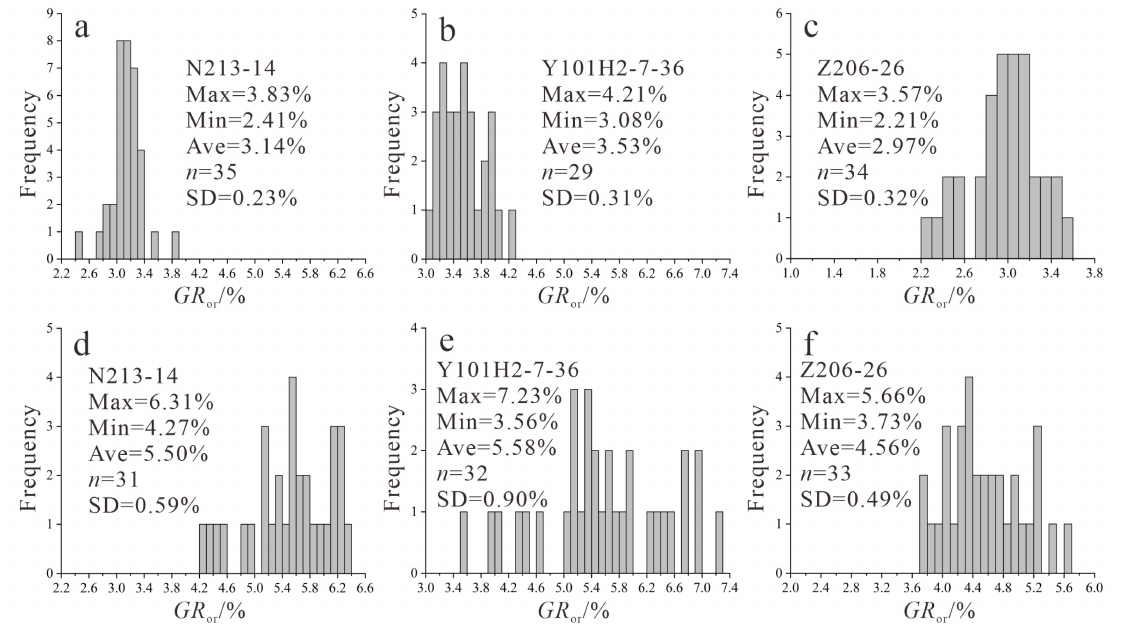
Figure 4. Comparison of the graptolite random reflectance of the Wufeng–Longmaxi Formations on sections perpendicular to bedding ( a – c ) and sections parallel to bedding ( d – f ) from southern Sichuan Basin. The average BR o of Type A in the Wufeng–Longmaxi Formations in the southern Sichuan Basin ranges from 2.11% to 3.56%, which is lower than that of non-granular graptolites (Table 1, Figure 5). The western Changning area has the highest BR o , ranging from 2.65% to 3.56%, with an average of 3.10%. In Luzhou-western Chongqing, BR o ranges from 2.31% to 3.15%, with an average of 2.73%. The BR o of eastern Changning ranges from 2.48% to 2.83%, with an average of 2.69%. The Weiyuan area has the lowest BR o , ranging from 2.11% to 2.53%, with an average of 2.39%. The BR o of Type A showed a good relationship with the GR or (Figure 6; R 2 = 0.69). With the increase in maturity, the growth rate of GR or is higher than the BR o of Type A. Both the GR or and the BR o of Type A can